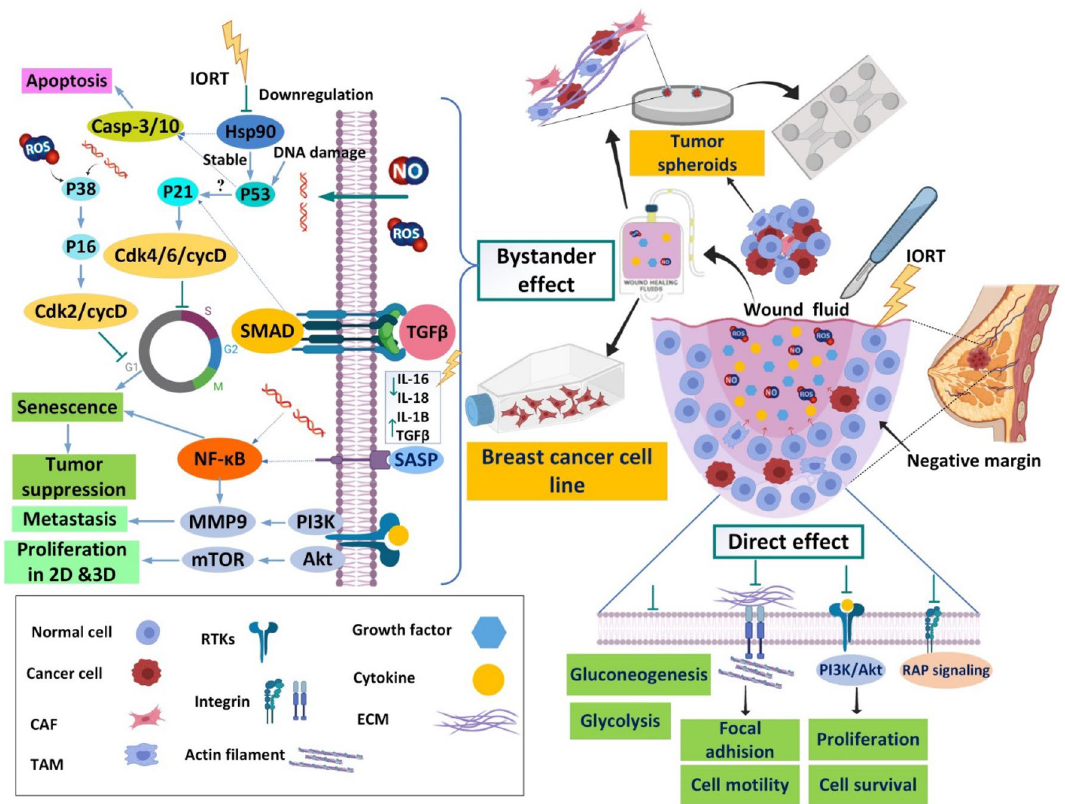
Figure 9. Proposed schematic showing direct and bystander effects of WF of IORT. After surgery, tumor spheroids were established to study the tumor behavior in 3D culturing in tumor on-chip. Tumor spheroids contain many cell types, cancer cells, cancer-associated fibroblasts (CAFs), and Tumor-associated macrophages (TAMs). Negative margin exposure to IORT shows the direct effect of radiation that inhibits several signaling pathways that its effect could target the residual cancer cells in the negative margin. Wound fluid (WF) produced in the surgical cavity contains several cytokines, growth factors, and free radicals after IORT, which have a bystander effect. After 24 h of IORT, WF was collected and studied on 3D spheroid and 2D cell culturing that show several biological processes, including arrested cell cycle through free radicals and DNA fragmentation, downregulation of Hsp-90 that stabilized TP-53 in cancer cells, upregulation P21 and P16 that promote cell cycle arrest and finally senescence. Senescence-associated secretory phenotype (SASP) factors also activated pathways to inhibit the cell cycle and activated several biological processes such as apoptosis and senescence. Growth factors were increased to promote the wound healing process in the surgical cavity after IORT and increase proliferation, motility, and migration of some spheroids and cell lines. The figure was created using Biorender (https:// biore nder.